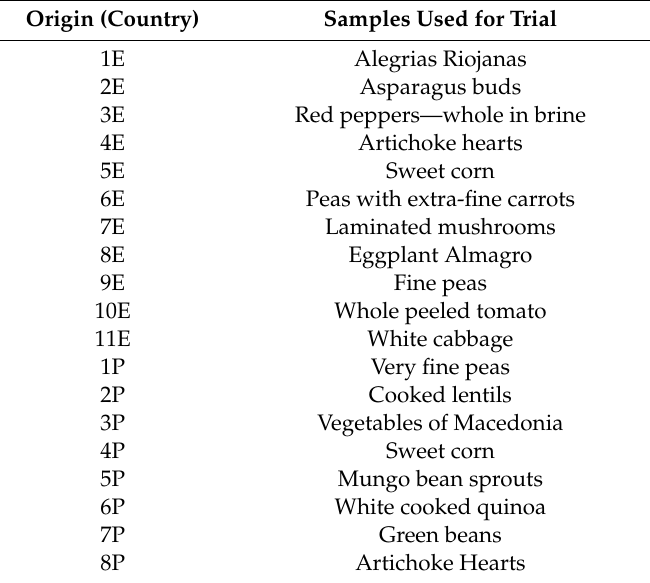
Table 1. Samples selected for the present study (P—Portugal; E—Spain). Origin (Country) Samples Used for Trial 1E Alegrias Riojanas 2E Asparagus buds 3E Red peppers—whole in brine 4E Artichoke hearts 5E Sweet corn 6E Peas with extra-fine carrots 7E Laminated mushrooms 8E Eggplant Almagro 9E Fine peas 10E Whole peeled tomato 11E White cabbage 1P Very fine peas 2P Cooked lentils 3P Vegetables of Macedonia 4P Sweet corn 5P Mungo bean sprouts 6P White cooked quinoa 7P Green beans 8P Artichoke